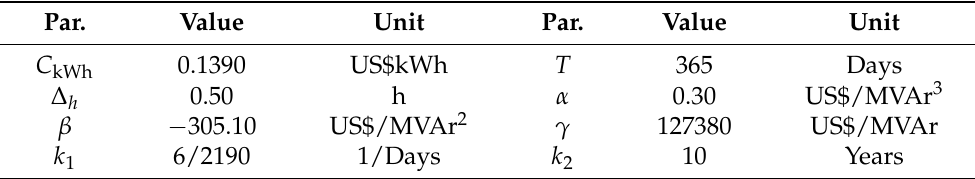
Table 5. Parametrization of the objective